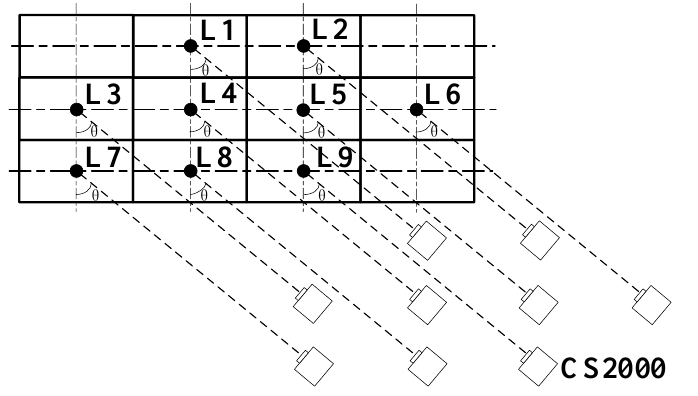
Figure 12. Schematic diagram of construction method. Table 1. The brightness of the display module with the same viewing angle selected by this experi- mental method (cd/m 2 ).